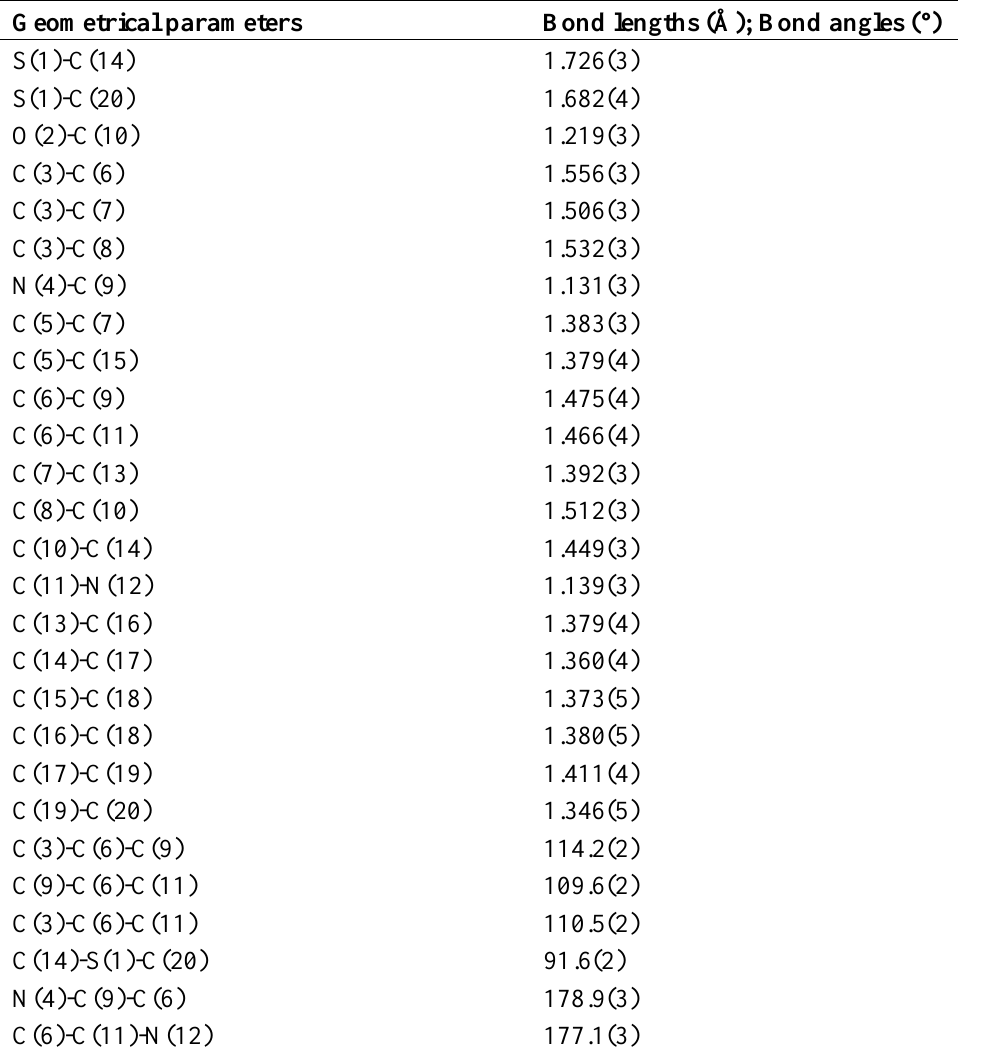
Table 2. Selected intramolecular geometrical parameters [bond lengths (Å); bond angles (°)] of 2 . Geometrical